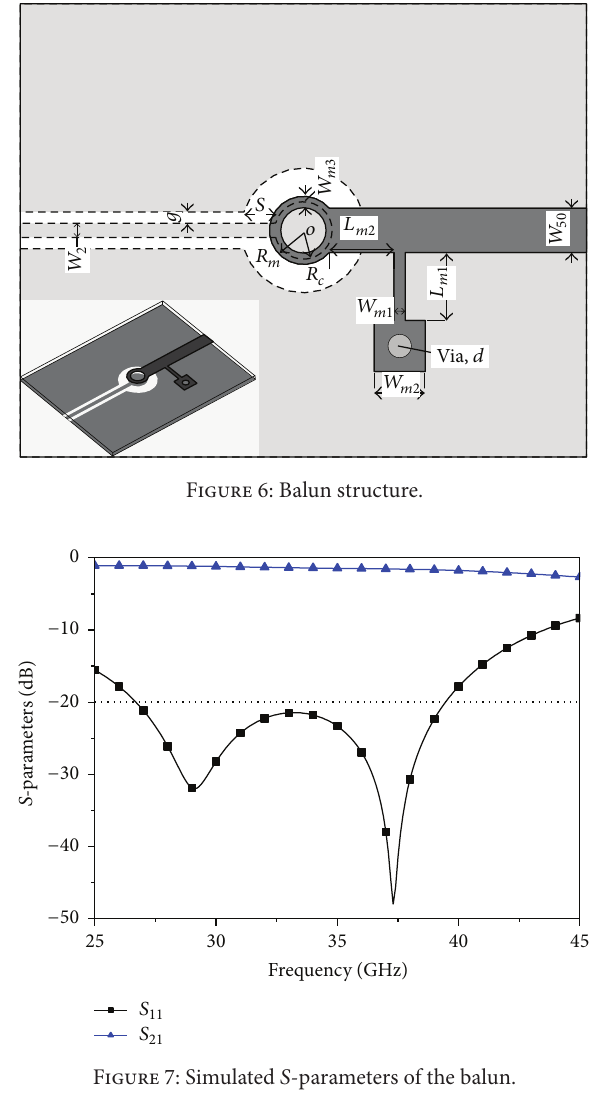
Figure 7: Simulated 𝑆 -parameters of the balun.